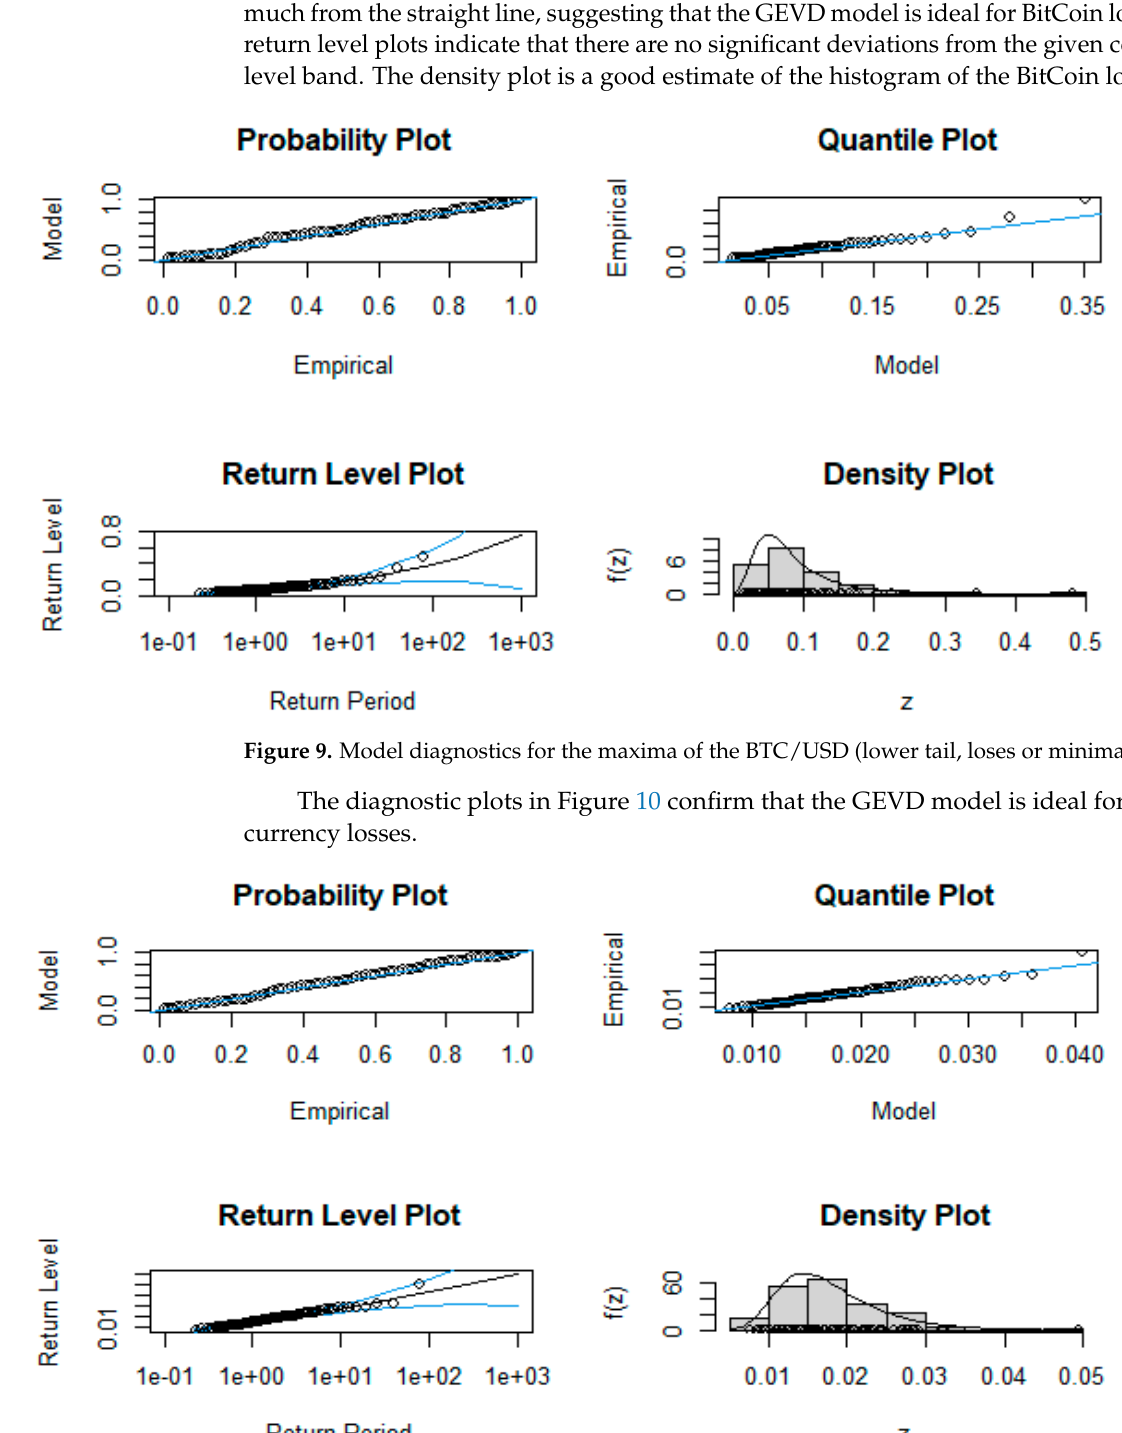
Figure 10. Model diagnostics for the maxima of the ZAR/USD (lower tail, loses or minima returns).